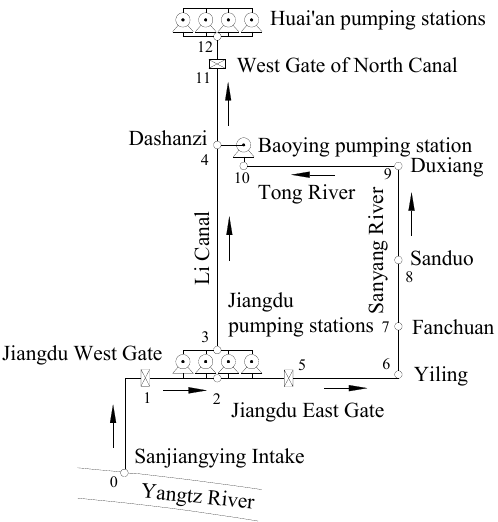
Figure 2. Diagram of parallel pumping stations in the open-channel water transfer system.